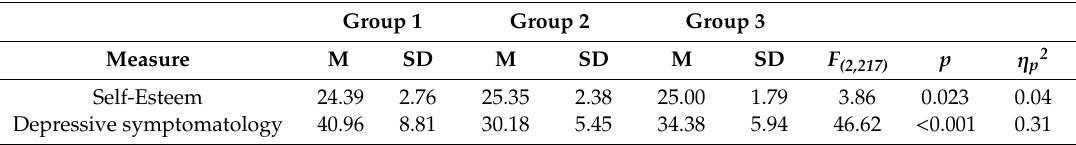
Table 3. Means (M) and standard deviations (SD) for the three groups for each measure of self-esteem and depressive symptomatology.